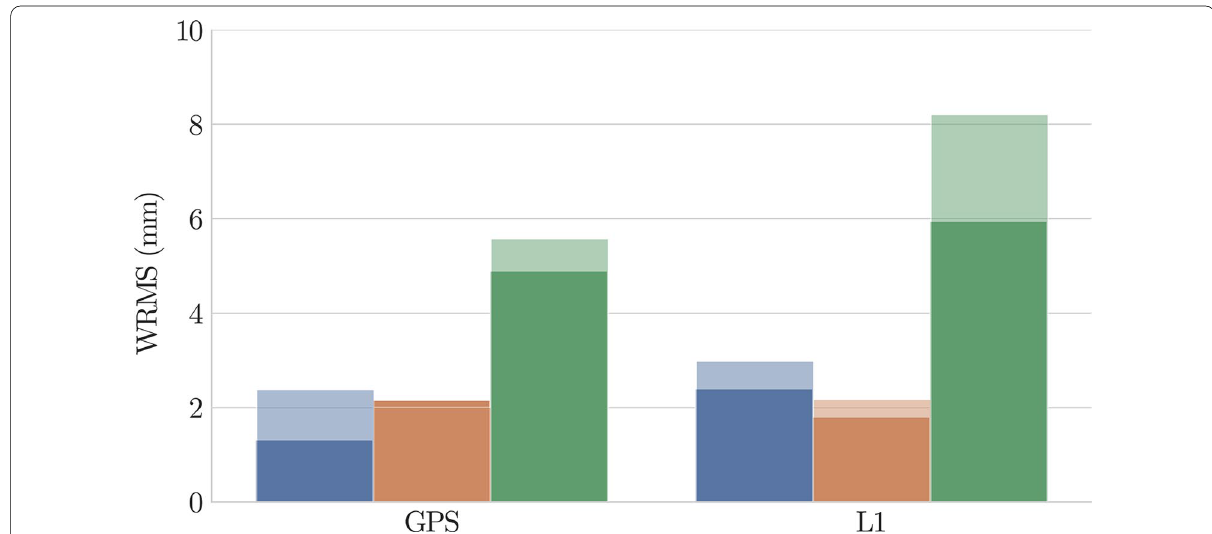
Fig. 5 Average station position repeatabilities (WRMS in mm) for the two co‑located networks (VLBI L1 sites on the right and GPS sites on the left) for a single‑technique solutions, i.e., sol‑V and sol‑G, (faded) and b the combined solution sol‑VG (colored). The results are computed based on the 15 daily solutions. The components evaluated are north (blue), east (orange) and up (green) of the local topocentric